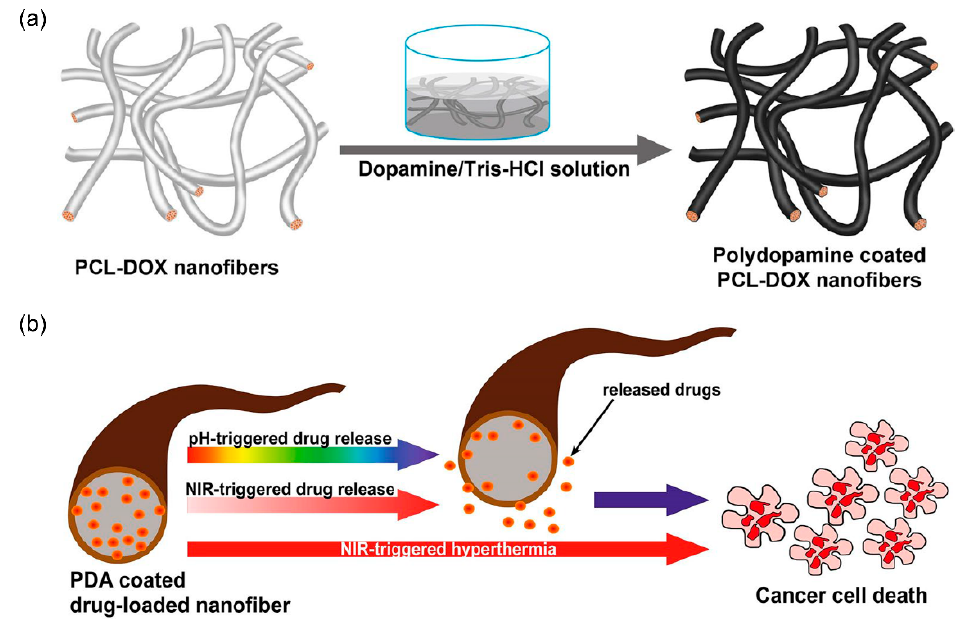
Figure 17. ( a ) Schematic of the fabrication procedure of the PDA modified PCL-DOX nanofibrous mat. ( b ) Schematic of cell death mechanism. Reproduced with permission from [94], CC BY license,